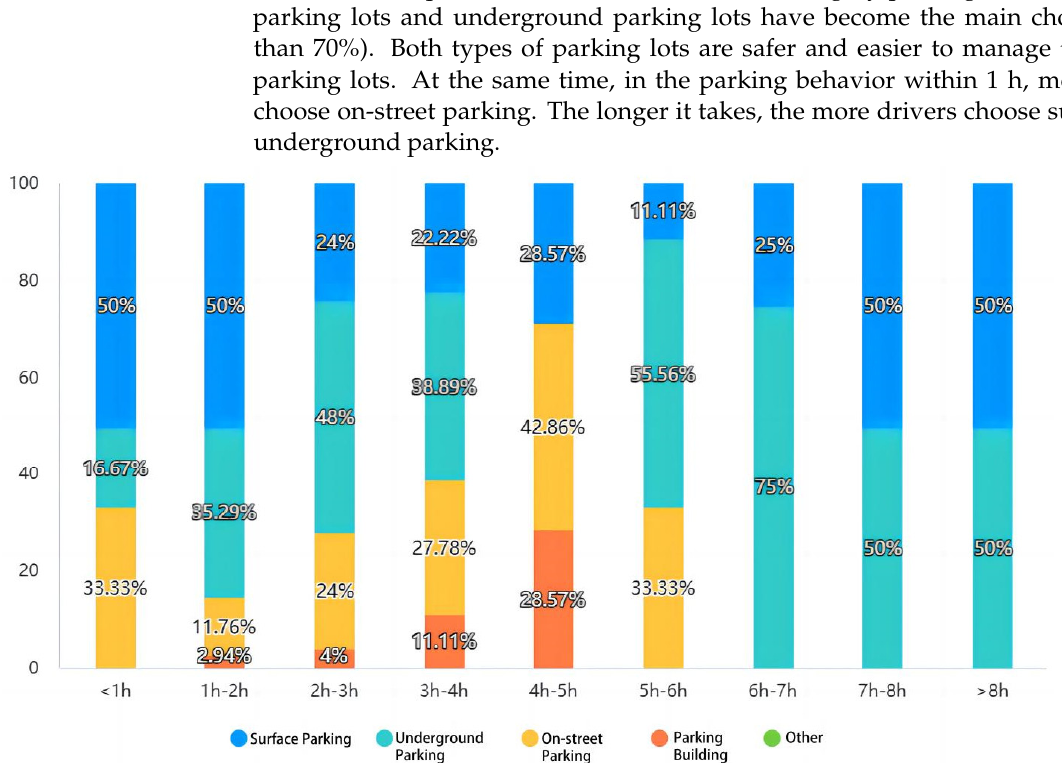
Figure 9. Parking hours correspond to different parking facilities.